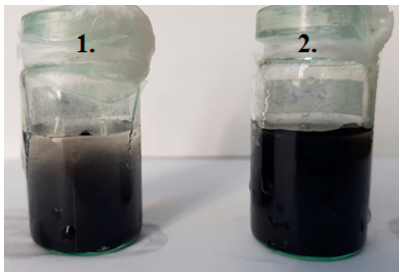
Figure 2. Aqueous dispersion of ( 1 ) pure MWCNTs and ( 2 ) functionalized